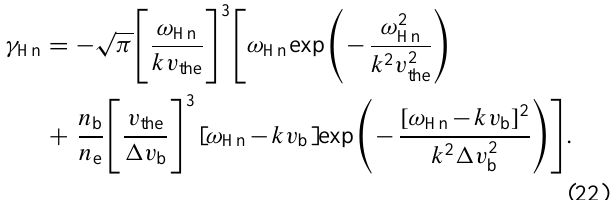
Fig. 2. Schematic of the simultaneous detection of enhanced IAW and LW. The wavenumbers in green would simultaneously detect both enhanced modes.